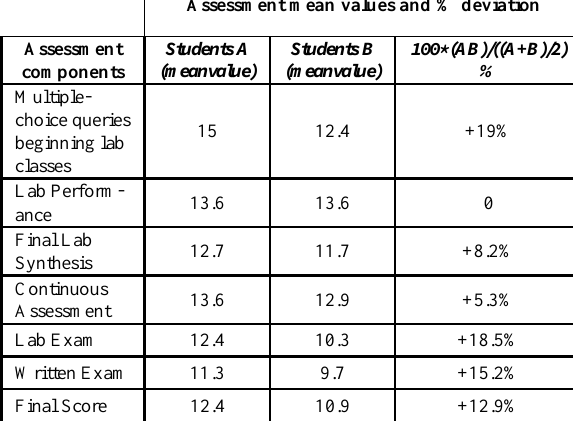
TABLE I. M EAN S CORE V ALUES OF A LL A